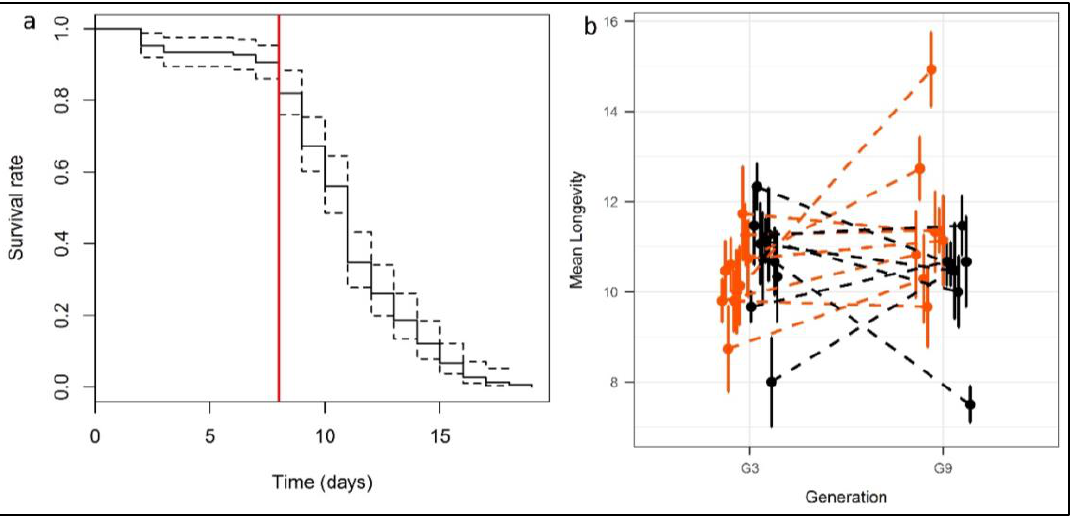
Figure 2. Evolution of fly survival. (a) Survival of female flies in the water condition at G3. Dotted lines represent the 95 % confidence interval. The red vertical line shows the age (8 days) at which reproduction was enforced during the experimental evolution. The corresponding figure for the paraquat condition is provided as supplementary material (b) Mean longevity (± standard error) in all lines in the paraquat (orange) and water (black) conditions, at generations 3 and